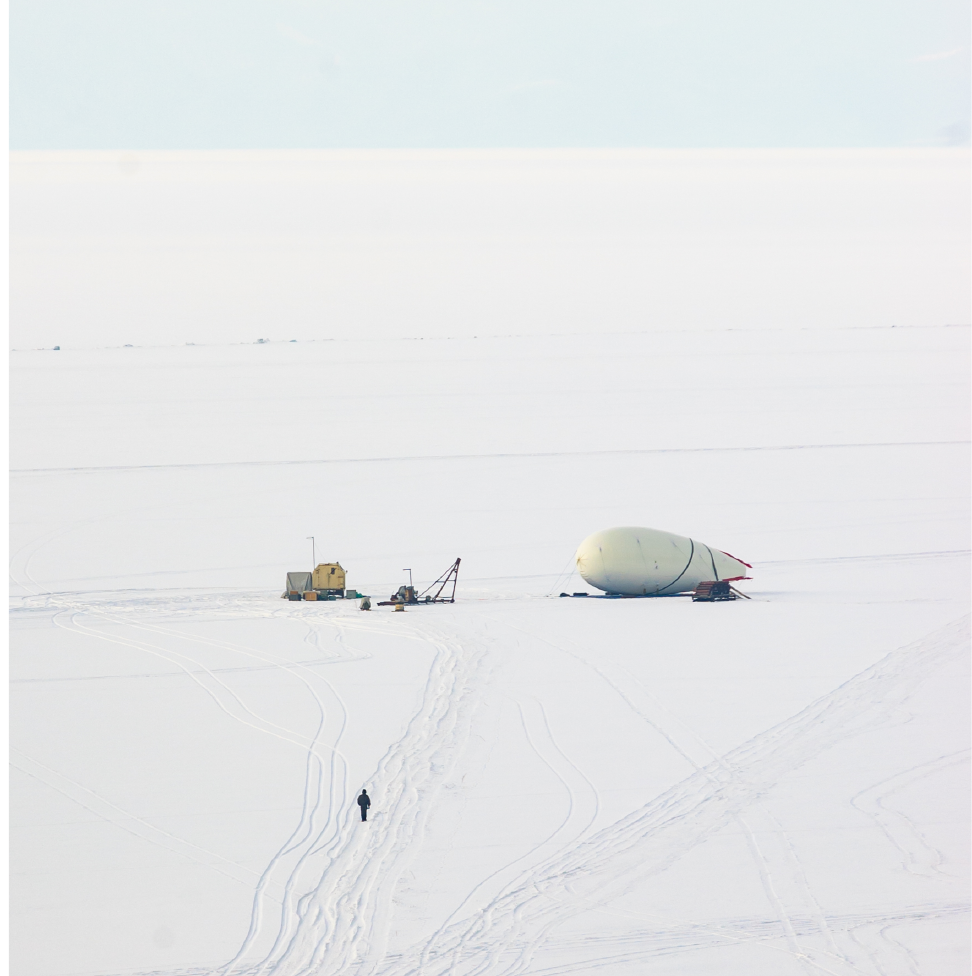
Figure 2. An overview of the launch site on the Baikal Lake from a hill on the shore. The snow coverage around the SPHERE start point was thick and usually renewed between flights by occasional